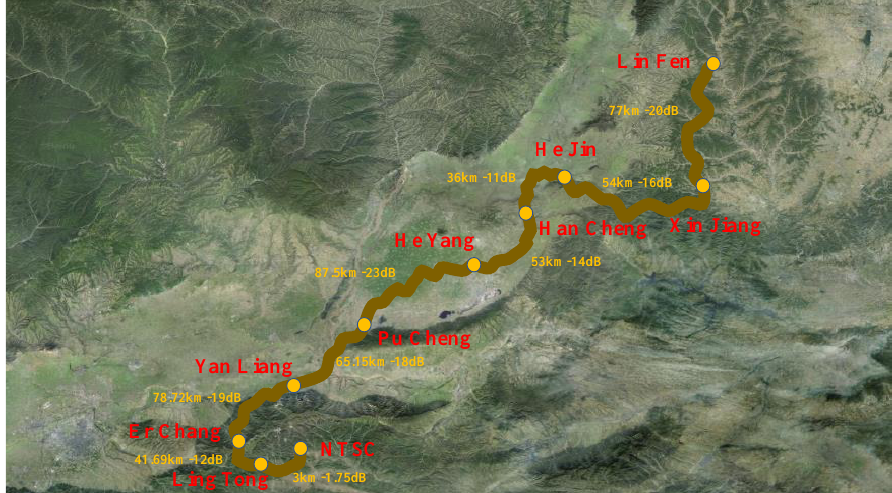
Figure 8. Route of the 988.52-km field optical fiber